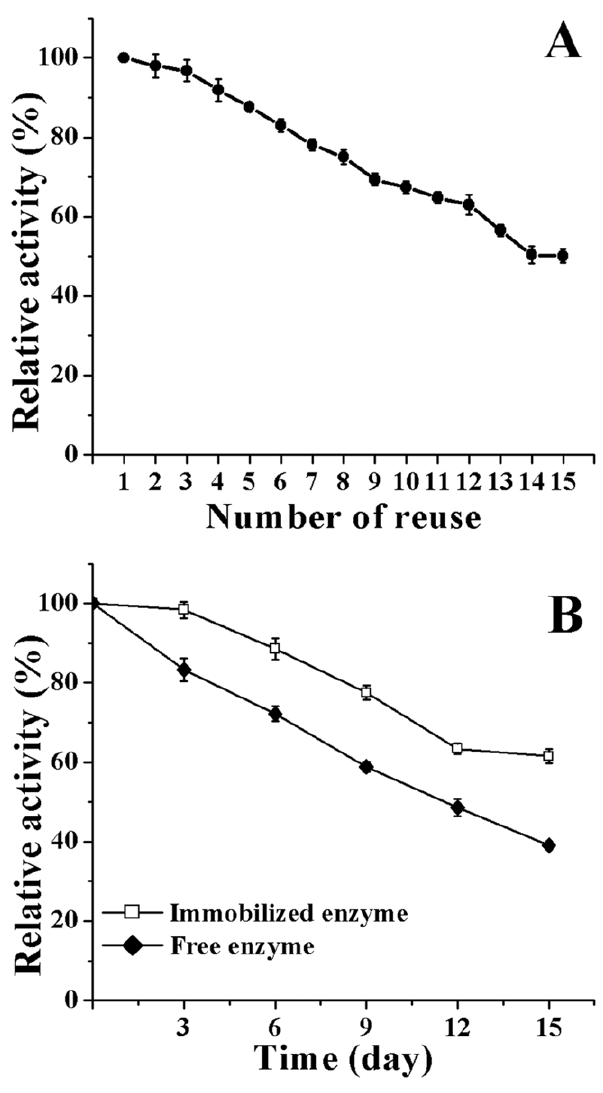
Figure 7. Reusability and storage stability of the immobilized v -TA. Changes in the activity of immobilized enzyme after multiple cycles of magnetic isolation and reuse (A). The activity of immobilized enzyme after multiple cycles of magnetic isolation and reuse at 37 u C (the initial activity of immobilized v -TA defined as 100%). The total elapsed time of the experiment was less than 8 hours. Storage stability of the free and immobilized enzyme (B). The samples were stored at 4 u C in PBS for 15 days, followed by determine the residual activity every 3 days.